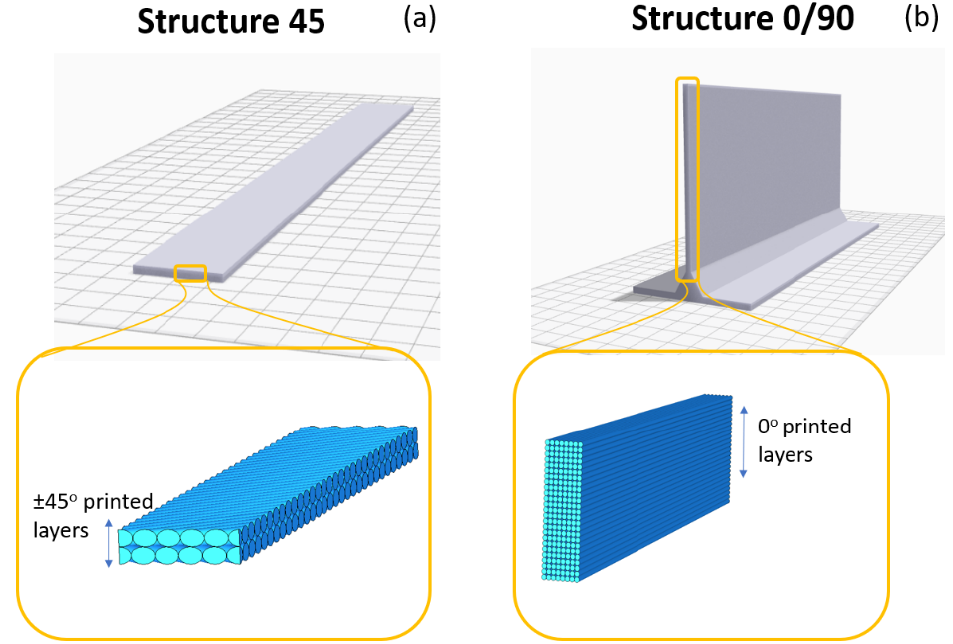
Figure 2. The geometry of the different printed structures. ( a ) Structure 45 containing the ±45° printed layers; ( b ) Structure 0/90 containing the 0° printed layers.